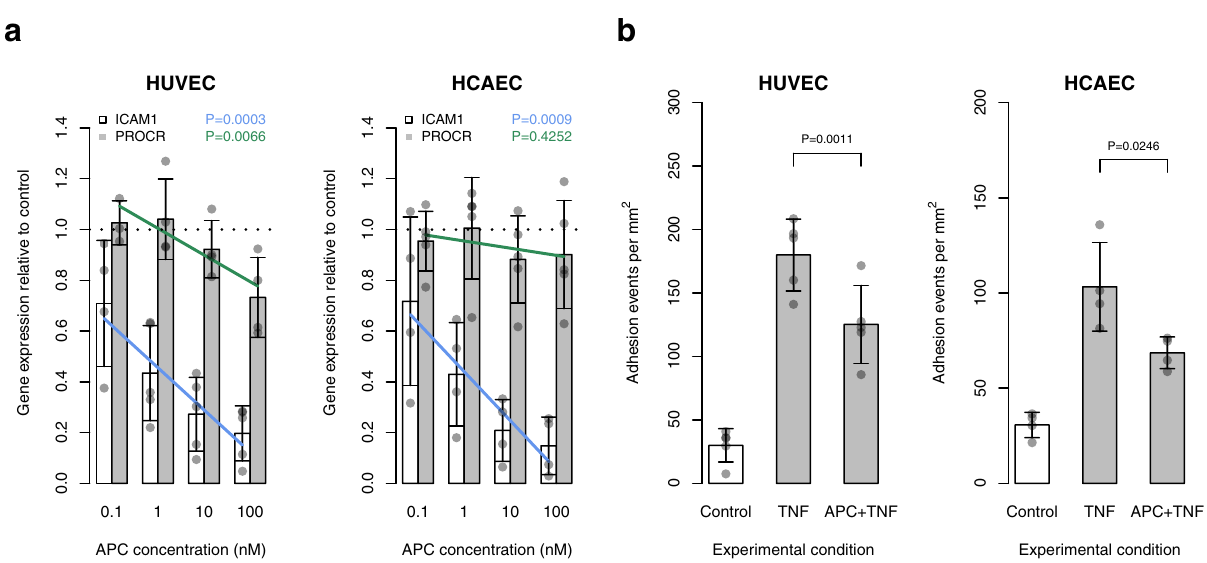
Fig. 5 Effect of APC on cell adhesion molecule expression and leukocyte – endothelial cell adhesion. a Barplots showing gene expression levels of ICAM1 and PROCR in human umbilical vein endothelial cells (HUVECs) and human coronary artery endothelial cells (HCAECs) relative to the control condition (i.e., 0 nM APC; indicated with a dashed line). Cells were co-incubated with 1 ng/ml TNF- α and varying concentrations of APC (0, 0.1, 1, 10, 100 nM) for 24 h. Data are shown for n = 5 ( ICAM1 ) and n = 4 ( PROCR ) biological replicates in HUVECs and n = 4 ( ICAM1 ) and n = 5 ( PROCR ) biological replicates in HCAECs. Error bars show standard deviations of the means. The blue and green lines indicate the fi tted linear regression model for gene expression level~log(APC concentration). P values for the F-test of the linear regression model are shown. For each biological replicate, three technical replicates were averaged. b Barplots showing mean cell adhesion events using static adhesion assays with PMA-stimulated monocytic cells (U937) and TNF- α -activated HUVECs or HCAECs. Cells were co-incubated with 1 ng/ml TNF- α and 100 nM APC for 24 h (Methods). Data are shown for n = 5 and n = 4 biological replicates in HUVECs and HCAECs, respectively. Error bars show standard deviations of the means. P values were calculated using paired one-tailed t -tests. For each biological replicate, 2 – 4 technical replicates were averaged.